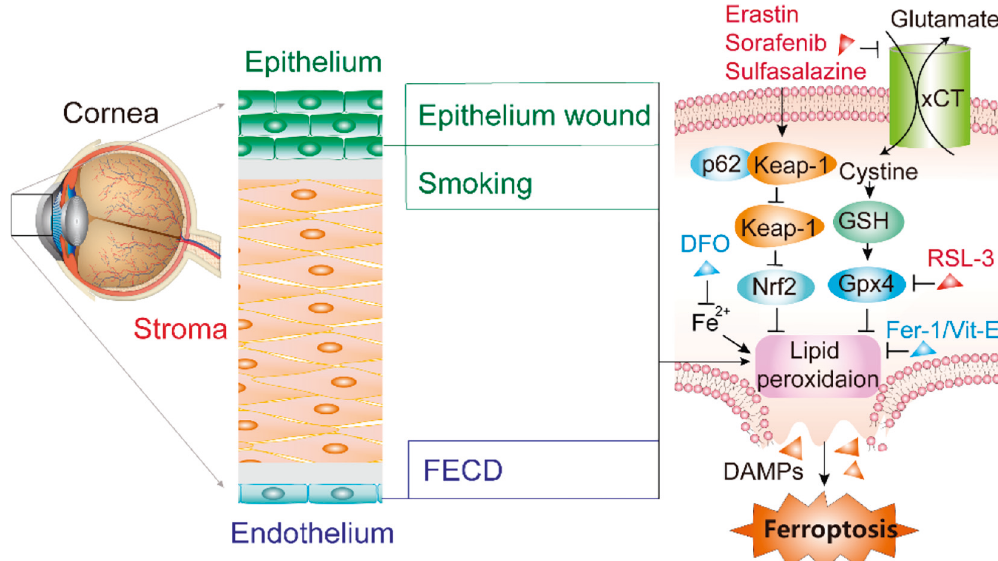
Figure 3: Schematic illustration of the potential contribution of ferroptosis to the death of corneal epithelial cells and corneal endothelial cells. Blue-colored words and red-colored words represent ferroptosis inhibitors and inducers, respectively. FECD, Fuchs’ endothelial corneal dystrophy; DFO, deferoxamine; GSH, glutathione; Fer-1, ferrostatin-1; Vit-E, vitamin E; DAMPs, damage-associated molecular